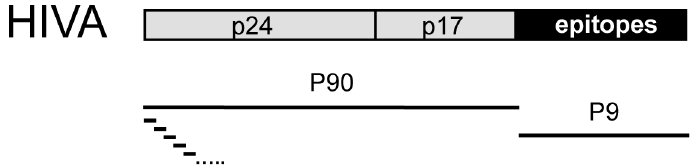
Figure 1. A schematic diagram of the HIV-1 clade A (HIVA) immunogen. The HIVA protein consists of consensus amino acid sequences of clade A p24 and p17 Gag and a string of partially overlapping CD8 + T-cell epitopes identified in chronically infected individuals [23]. Pool P90 of 15-mer peptides overlapping by 11 amino acids across the Gag portion is shown below the protein. Pool P9 consisted of known CD8 + T-cell epitope peptides derived from the polyepitope region. doi: